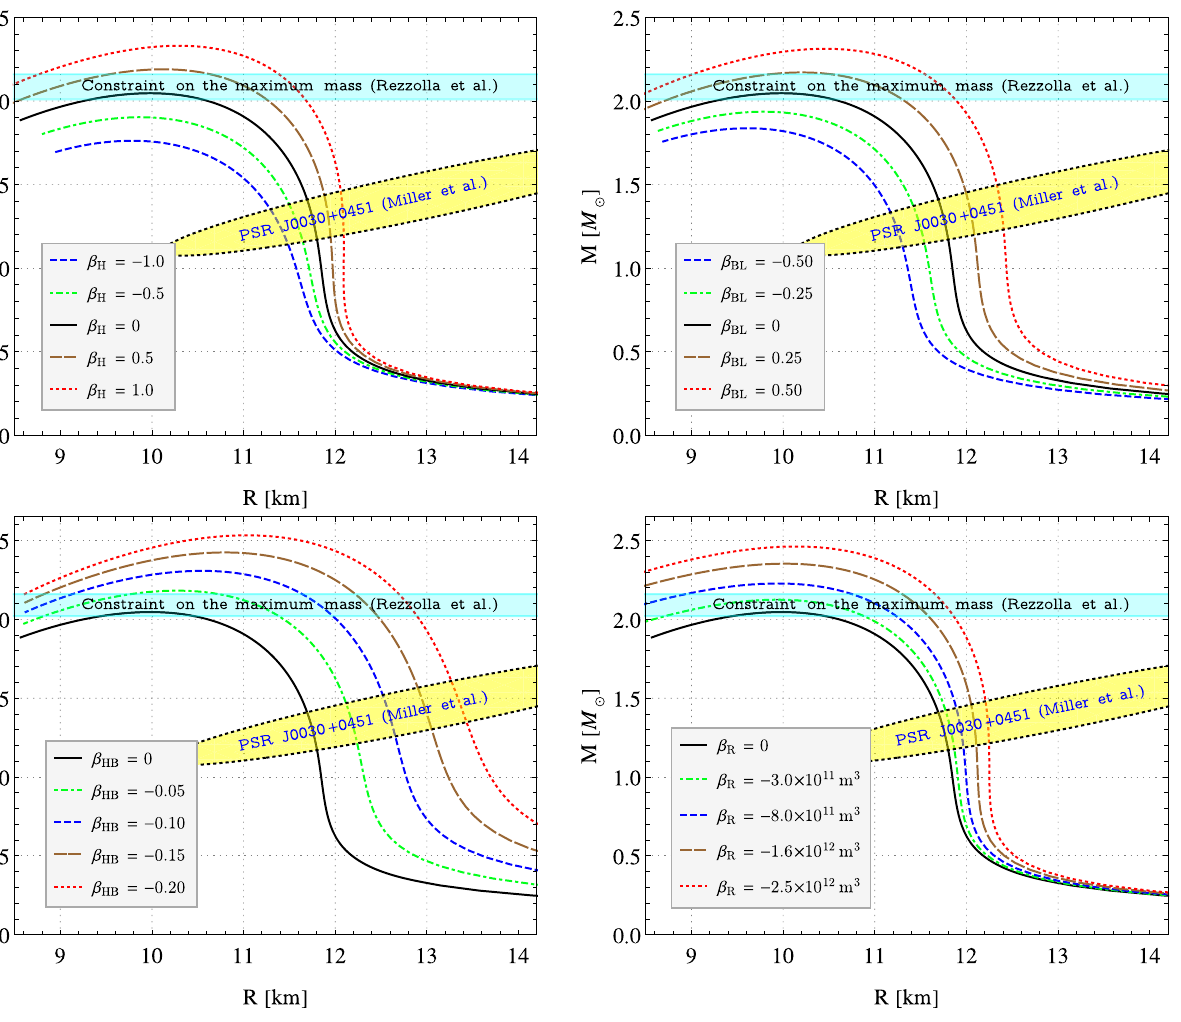
Fig. 1 Mass-radius diagrams for anisotropic neutron stars with SLy EoS (29) and for the anisotropy ansatze (30) in the upper left panel, (32) in the upper right panel, (34) in the lower left panel, and (36) in the lower right panel. The isotropic case is shown in all plots as a bench- mark by a solid black line, and the cigar-shaped yellow region is one